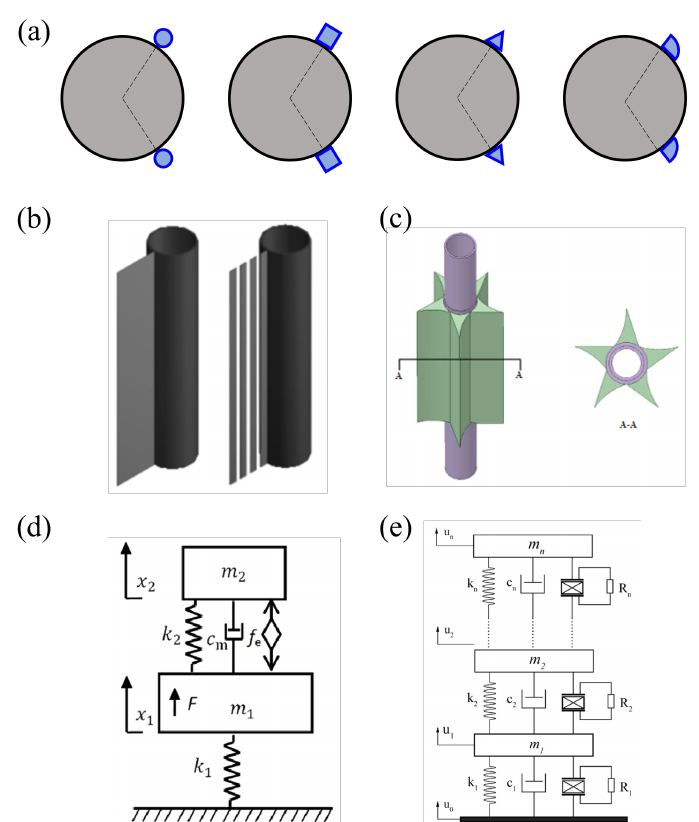
Figure 11. Strategies to improve the power production from a vibrating cylinder undergoing FIV for energy harvesting: ( a ) attaching small rods (circular, square, triangular, fin-shaped); ( b ) attaching a splitter plate (solid and slotted) [245]; ( c ) attaching a free-to-rotate pentagram impeller [238]; ( d ) incorporating a dual-mass system [241]; and ( e ) utilizing a multi-degree-of-freedom system with multiple piezoelectric elements